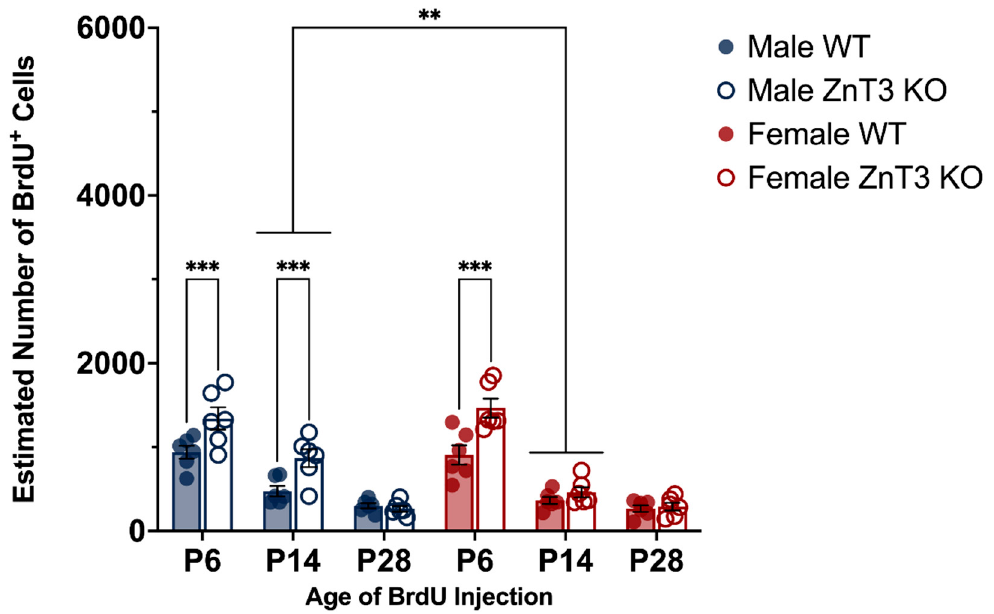
Figure 5. Survival of cells labelled at P6, P14, and P28, as measured by BrdU + cells at P60, in male and female WT and ZnT3 KO mice. BrdU was administered to male and female WT and ZnT3 KO mice on P6, P14, or P28 to label dividing cells ( n = 6 per group). To assess the cell survival, brains were collected on P60, and BrdU + cells were counted in the SGZ and GCL. Male ZnT3 KO mice injected on P6 and P14 had significantly higher numbers of BrdU + cells that survived to P60 compared to male WT mice. Female ZnT3 KO mice injected on P6 also had significantly more BrdU + cells remaining at P60 compared to female WT mice. Male mice injected on P14, regardless of genotype, had significantly higher numbers of BrdU + cells that remained at P60 compared to female mice. Error bars represent ± standard error of the mean. ** Indicates p < 0.010; *** indicates p < 0.001.